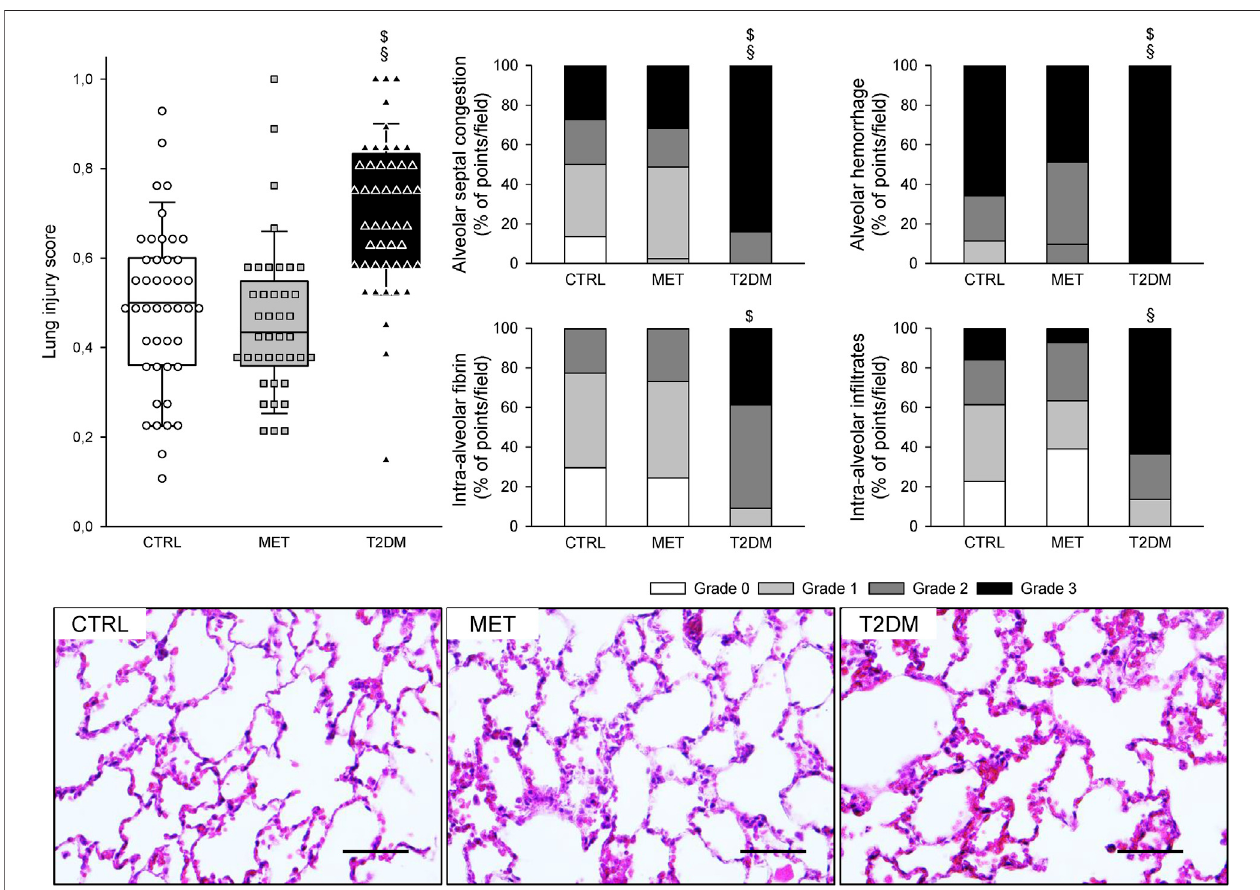
FIGURE 5 | Lung injury score (LIS) in control rats (CTRL), in rats with metformin-treated type 2 diabetes (MET), and in rats with untreated type 2 diabetes (T2DM) anditscomponentsdescribingthedifferenttypesoflunginjuries.EachsymbolrepresentstheLISvalueona fi eldofview.Representativeimagesoflungsectionsstained with hematoxylin and eosin are also demonstrated (magni fi cation × 400; scale bar: 50 µm). $ p < 0.05 vs . CTRL; § p < 0.05 vs . MET.